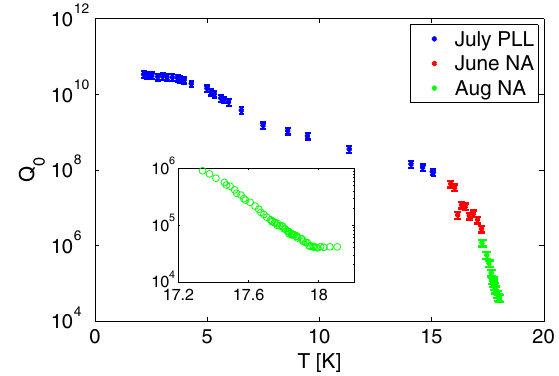
FIG. 9. Q vs T of the cavity B measured with phase lock loop (PLL) or with network analyzer (NA) with weak coupling such that the Q 0 ∼ Q L (left); R s vs T of cavity B from PLL data and polymorphic BCS fit